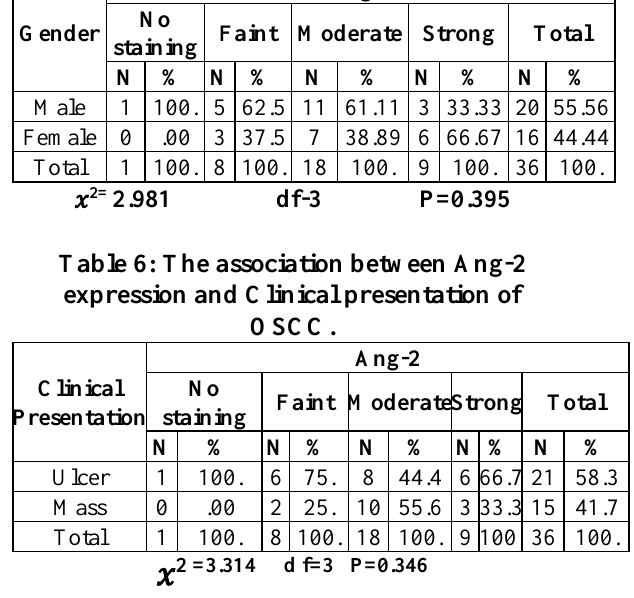
Table 2: The distribution of study sample according to the histopathological grade of the Tumor. Grade well differentiated